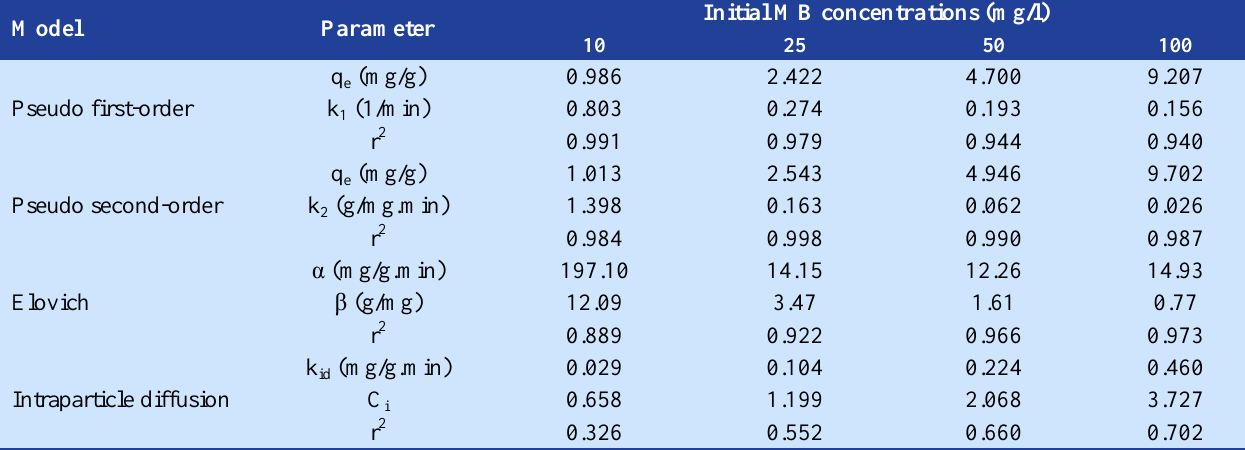
Table 4. Kinetic parameters of methylene blue (MB) adsorption onto acid-activated spent tea (AAST) surfaces using non-linear regression approach Model